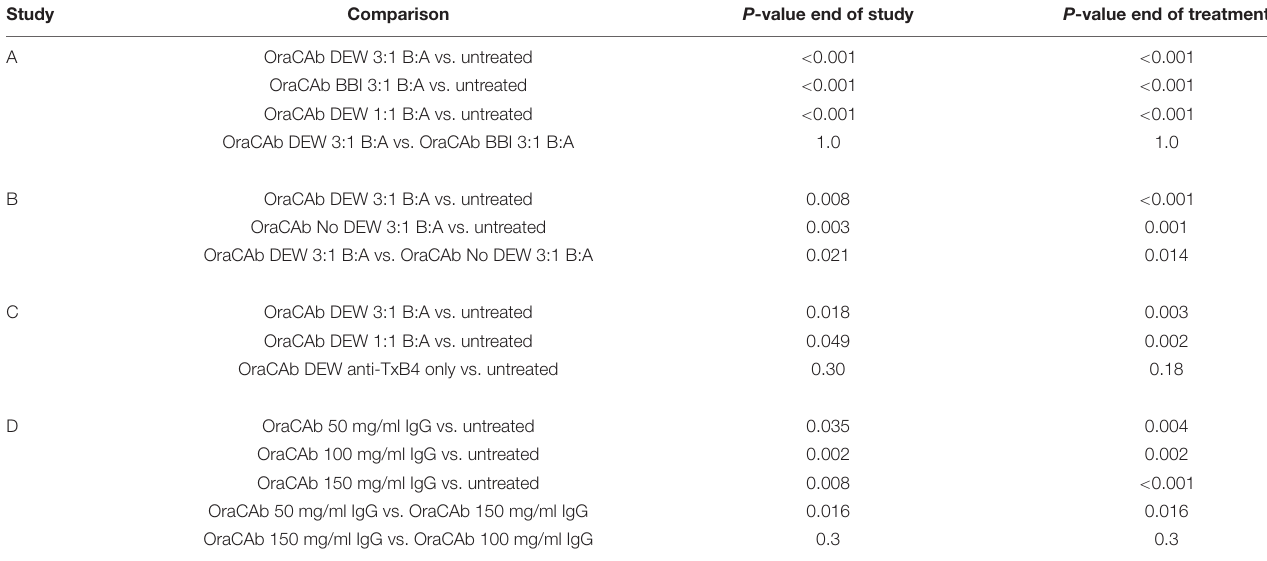
TABLE 2 | P -values calculated for different treatments in the in vivo model of CDI.